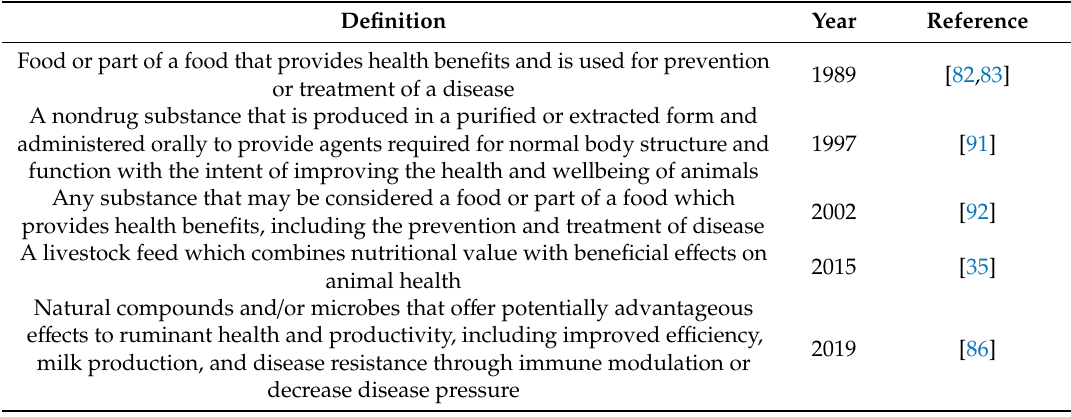
Table 2. The evolution of the nutraceutical concept for non-ruminants and ruminants over